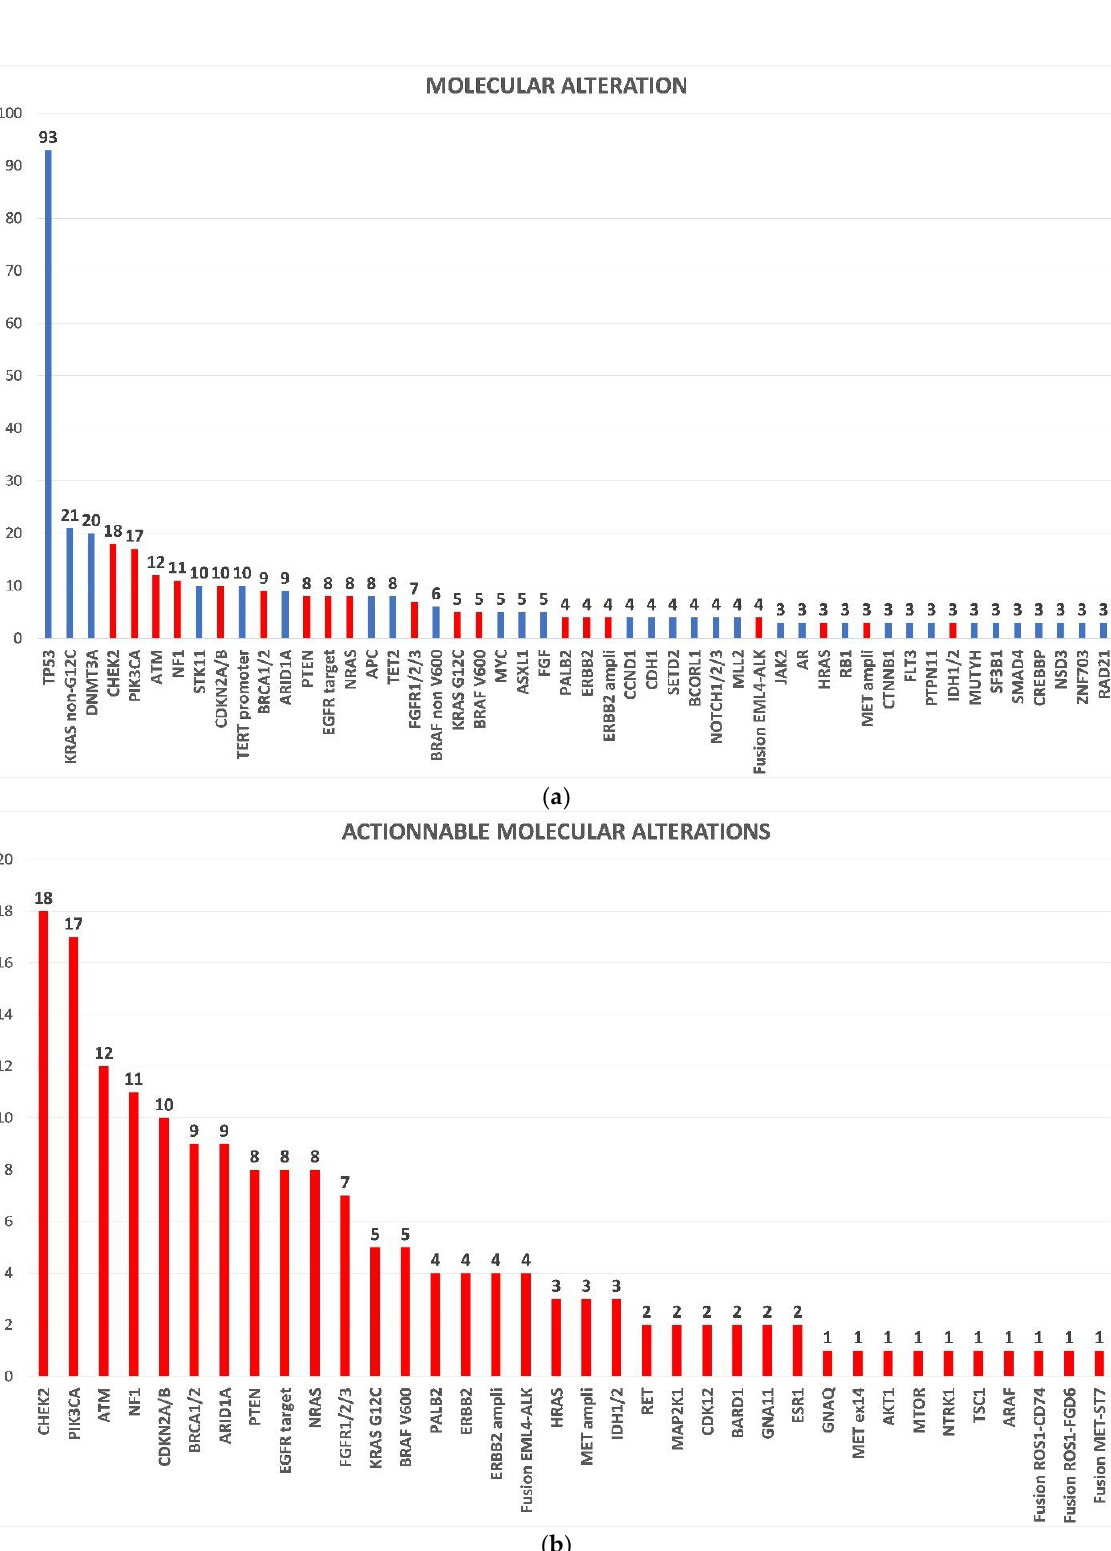
mutation (8%) and PIK3CA mutation (8%) (Table S1, Supplementary Materials). The me- dian variant allelic frequency (VAF) of these targeted AMA was 6.8% (range: 0.15 – 50.9) and 11/37 patients (30%) had a VAF > 10%.